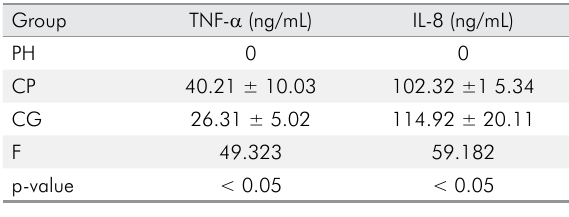
Table 6. RNA expression measurement results.